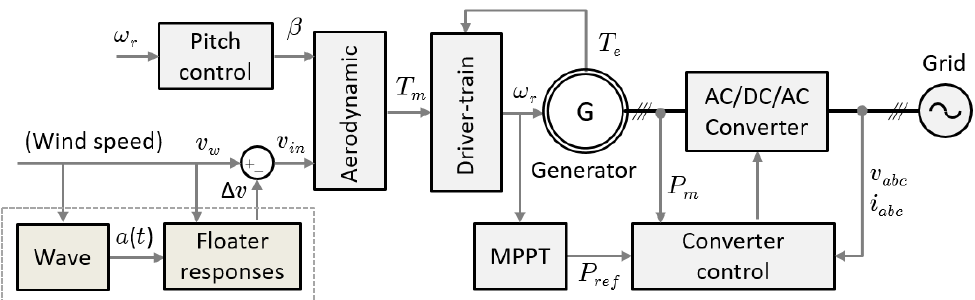
Figure 2. Overall configuration of simplified FOWT